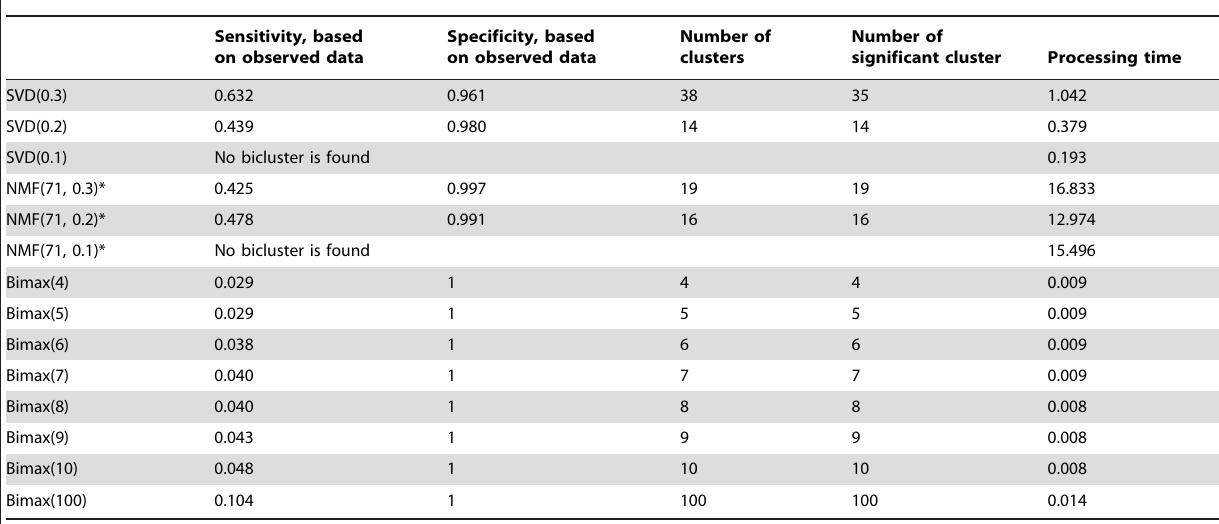
Table 4. Performance of SVD( d ), NMF( f , d ), and Bimax( k ) on the PFGE dataset consisting of the 4 serotypes, Heidelberg (n=322), Javiana (n =150), Newport (n= 91), and Typhimurium (n= 135), for a total of 698 isolates with 71